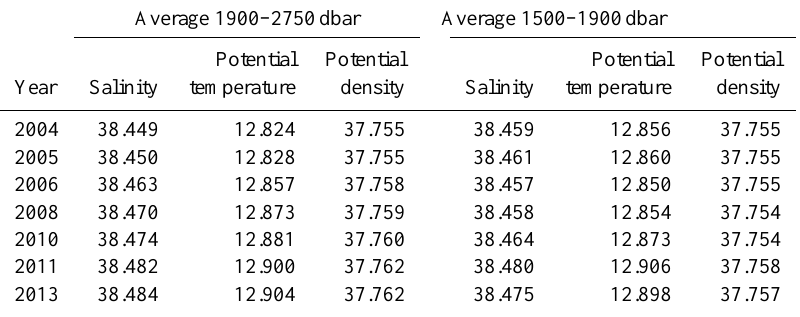
Table 2. Depth-average salinity, potential temperature and potential density referenced to 2000dbar at station 9 in the western Mediterranean over the past decade: deep water 1900–2750dbar and above the direct influence off deep water formation 1500–1900dbar. Potential density referenced to 2000dbar is defined as density – 1000 in units of kg m − 3 . Stations in 2004, 2005, 2006, 2008, 2010, 2013 were occupied by RV Urania as part of CNR repeat surveys of the western Mediterranean Sea; the station in 2011 was occupied by R/V Meteor during a west–east transect of the Mediterranean (Tanhua et al., 2013). CTD station data have a precision in salinity of 0.003 and in temperature of 0.001 ◦ C. Differences in expedition methodologies and instrumentation lead to possible biases in salinity and temperature of 0.01 and 0.005 ◦ C between